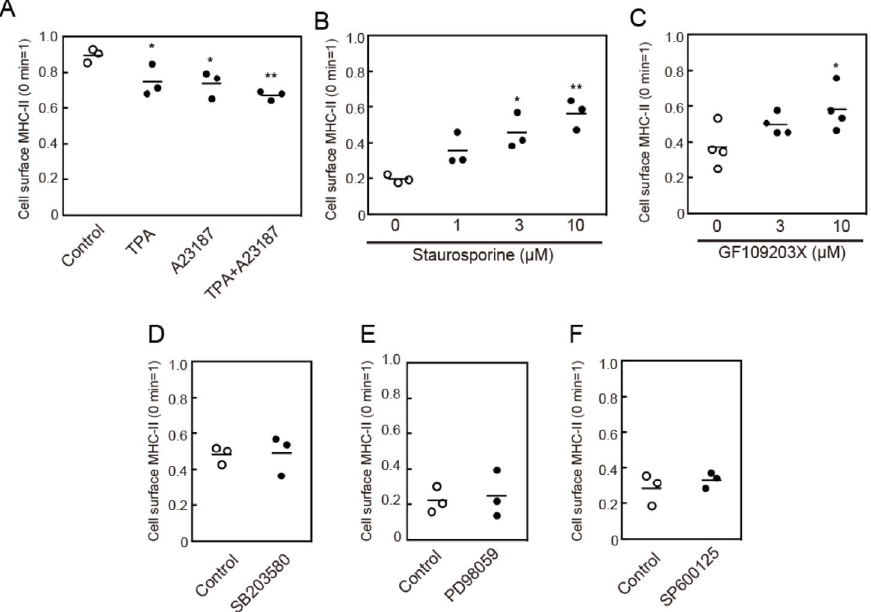
Figure 5. Protein kinase C (PKC) activation induces MHC-II endocytosis. ( A ) BMDCs were incubated with an anti-MHC-II antibody for 30 min at 4 °C. The cells were washed and stimulated with 12-O- tetradecanoyl phorbol 13-acetate (TPA) (100 nM) and A23187 (1 µM) for 30 min at 37 °C. The remaining cell surface anti-MHC-II antibody was detected using a PE-labeled anti-mouse IgG antibody. ( B , C ) BMDCs were pre-incubated with staurosporine for 15 min or GF109203X for 30 min at the indicated concentrations of 37 °C. The cell surface MHC-II was crosslinked using an anti-MHC-II antibody. ( D – F ) BMDCs were pre-incubated with SB203580 (10 µM) for 30 min, PD98059 (50 µM) for 15 min, or SP600125 (20 µM) for 15 min, at 37 °C. The cell surface MHC-II was crosslinked using an anti-MHC-II antibody for 30 min. The remaining cell surface MHC-II was detected by flow cytometry. Values of * p < 0.05, ** p < 0.01 are regarded as significant.